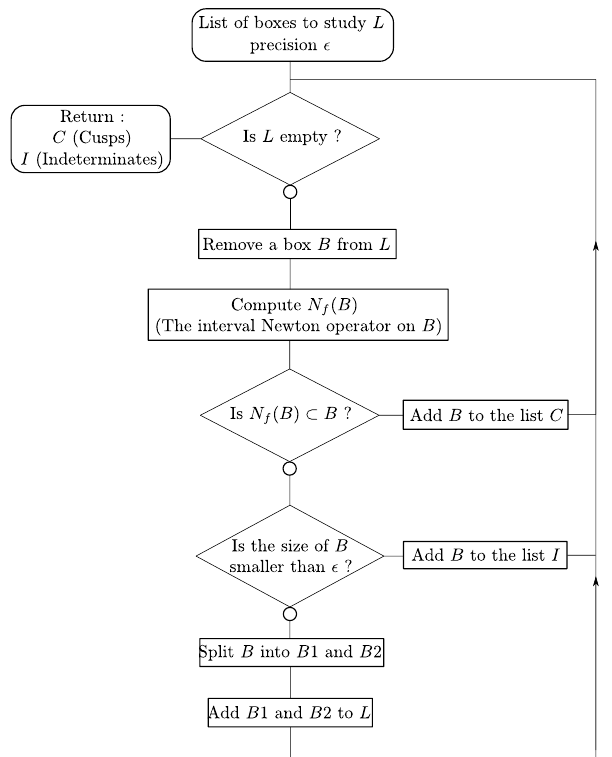
Figure 4. Interval Newton Algorithm.